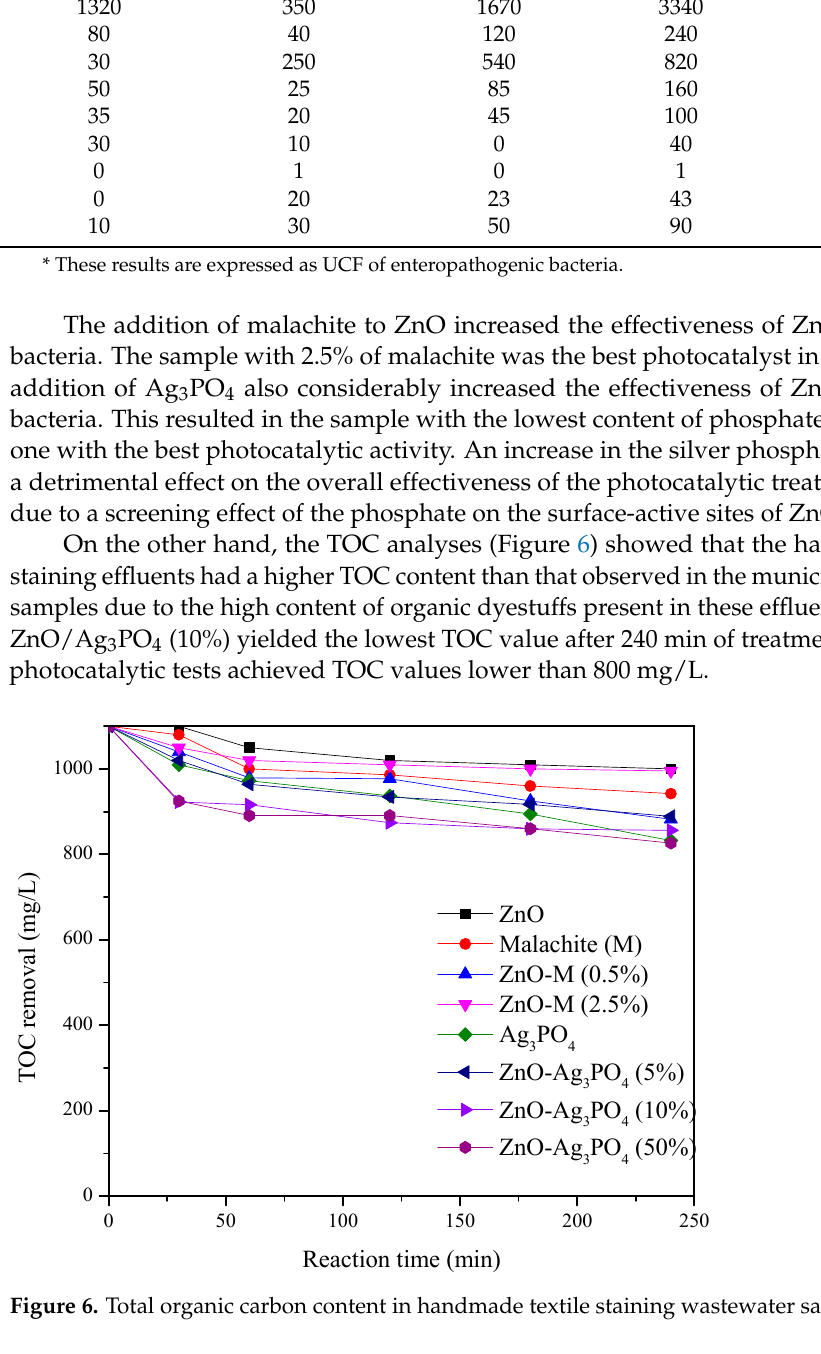
Table 4. Enteropathogenic bacteria removal from samples of handmade textile staining wastewater.